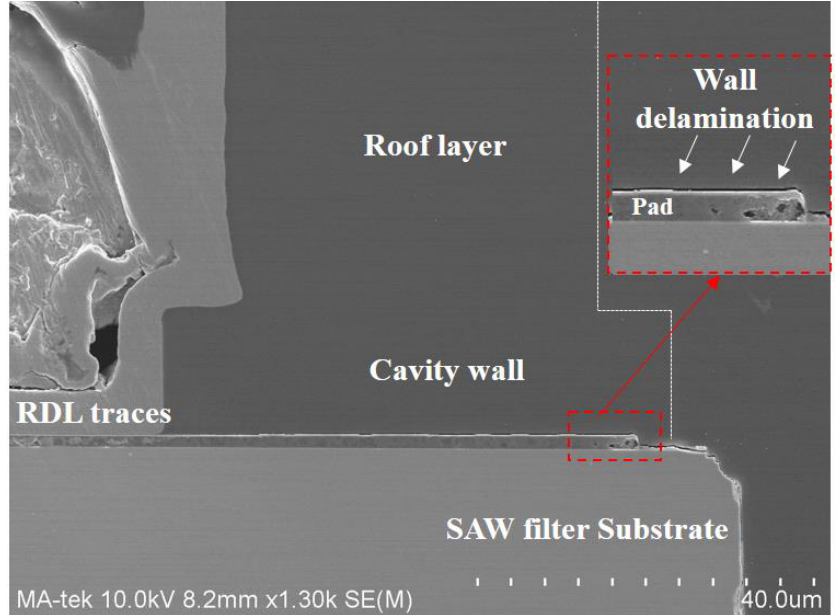
Figure 8. SAW filter package failure modes after TC test. (The arrow, in this Figure, refers to a magnified image of the delamination between the wall layer and substrate).